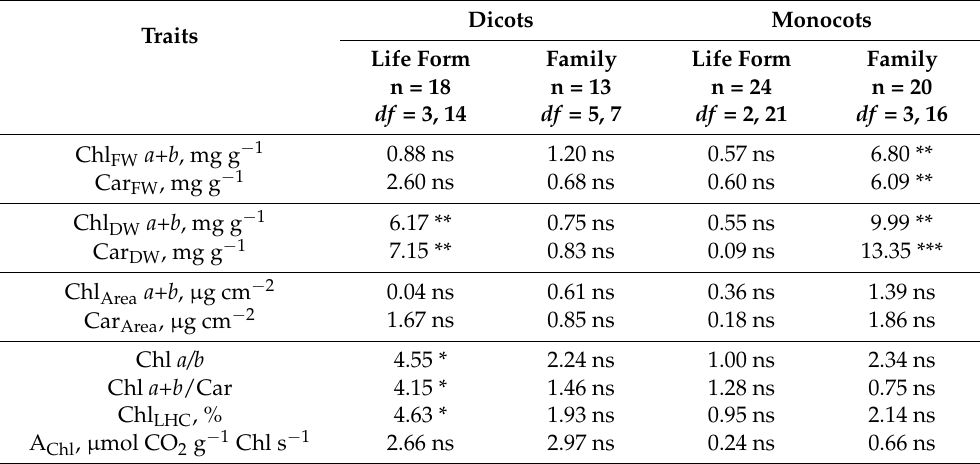
Table 2. Results of one-way ANOVA of leaf pigment complex traits in dicotyledonous and mono- cotyledonous wetland plants. F values and their significance (ns, not significant; *, p ≤ 0.05; **, p ≤ 0.01; ***, p ≤ 0.001) are presented.